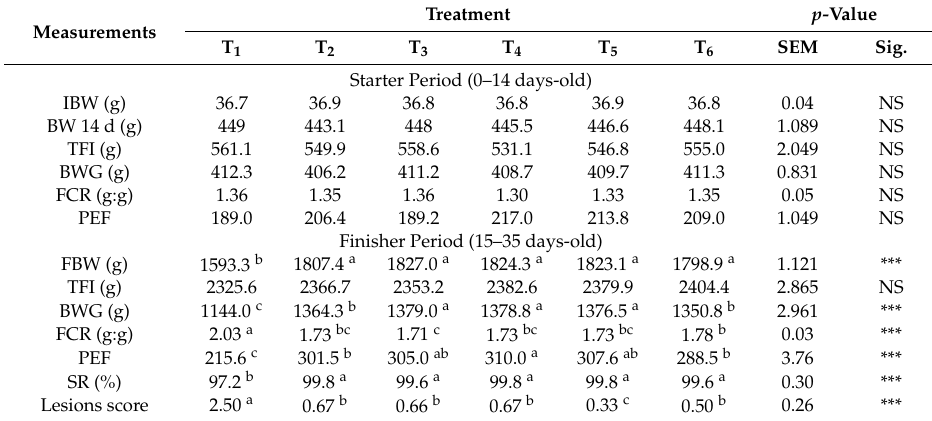
Table 2. E ff ects of some feed additives on the growth performance, survival rate, and intestinal lesion score of broilers challenged with C. perfringens during the starter and finisher feeding periods. Measurements